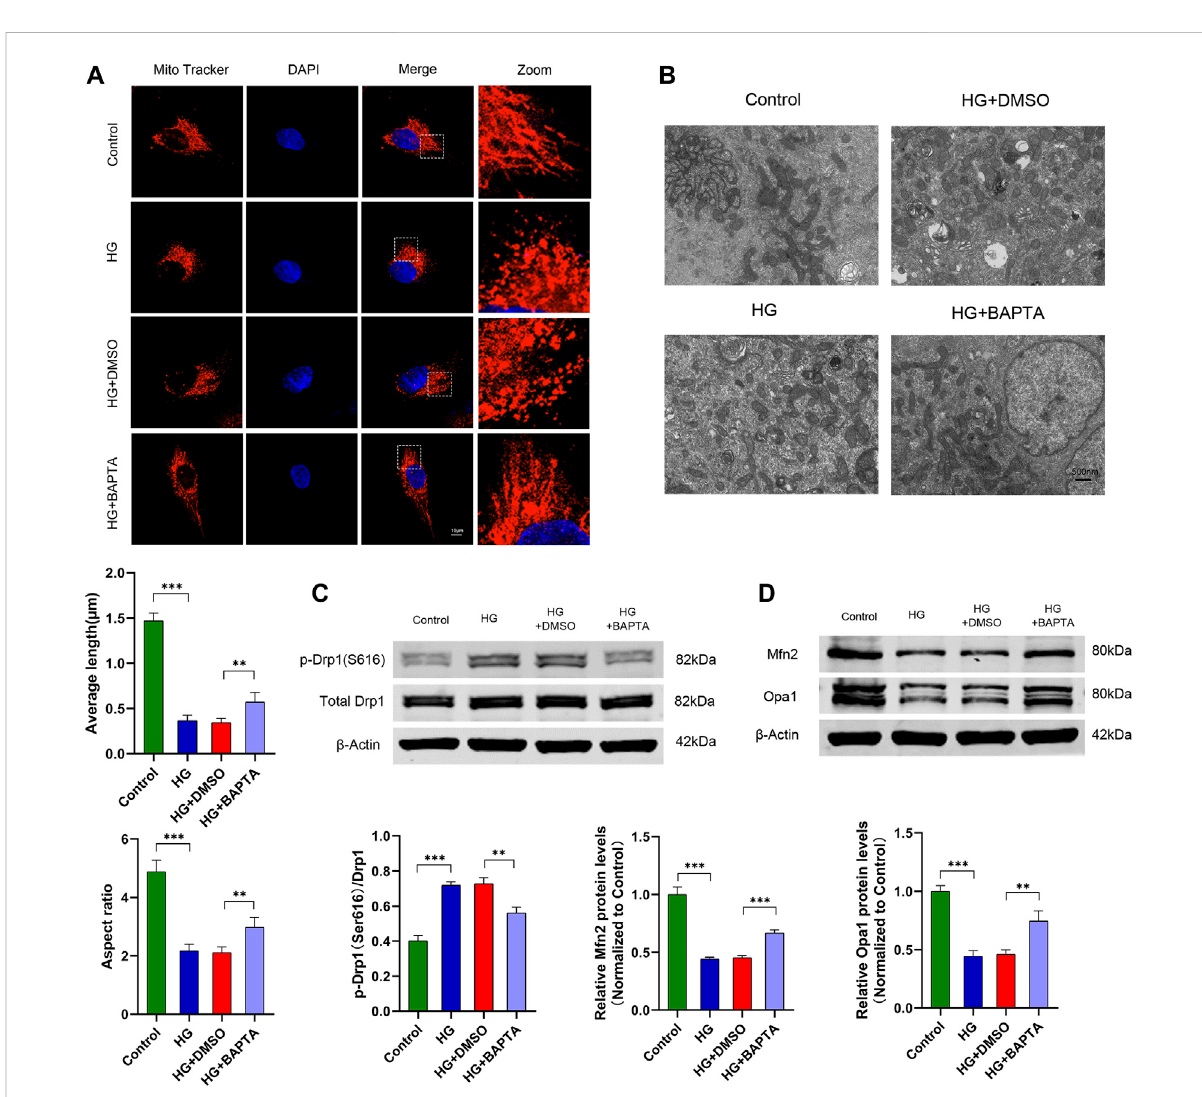
FIGURE 4 BAPTA-AMalleviatesHG-inducedmitochondrial fi ssioninpodocytes. (A) MitoTrackerRedandDAPIstaining,andanalysisofaveragelengthand aspect ratio by ImageJ software in the control, HG, HG + DMSO and HG + BAPTA groups. Scale bars, 10 μ m ( n = 5 independent experiments). (B) Representative electron micrographs in the four groups. Scale bars, 500 nm. (C) Representative Western blot and quantitation analysis of p-Drp1 (Ser616) and total Drp1 in the four groups ( n = 3 independent experiments). (D) Representative Western blot and quantitation analysis of Mfn2 and Opa1 in the four groups ( n = 3 independent experiments). ** p < 0.01; *** p <